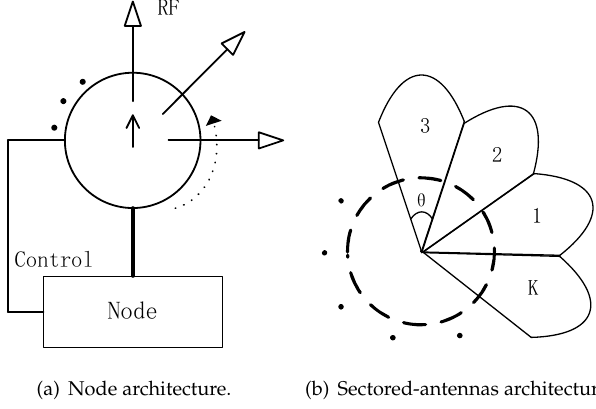
Figure 1. Node and sectored-antennas architecture of traditional scan-based algorithm (SBA) algorithm.